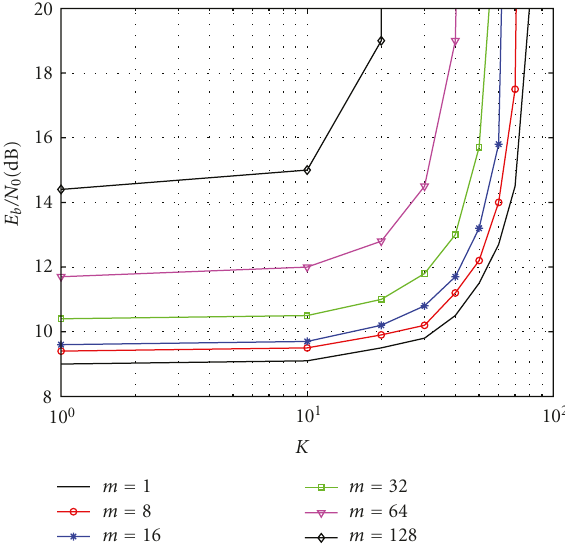
Figure 5: SNR required for a convolutionally coded FHSS system to achieve P b = 10 − 5 over Nakagami fading versus the number of users K with perfect CSI for m = 1,8,16,32,64,128 and SIR =